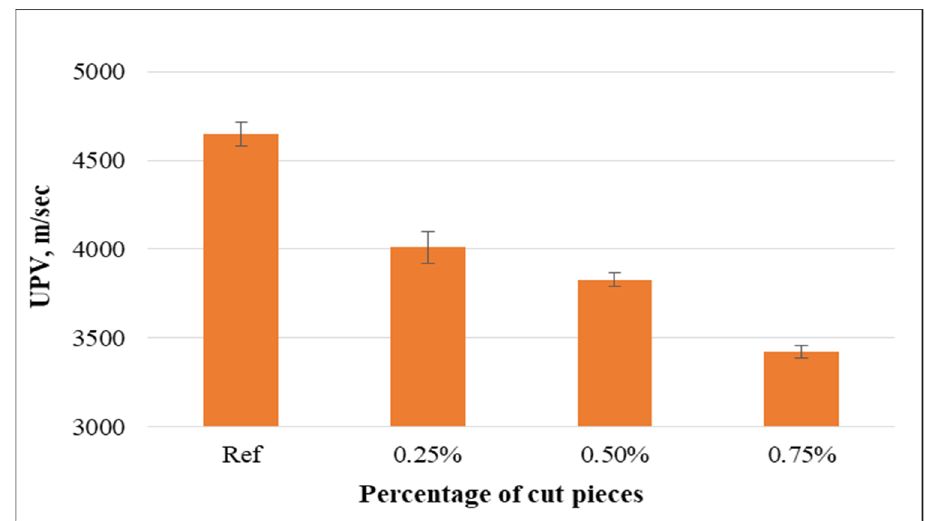
Figure 23. Relationship between UPV and volume fraction of non-woven cut pieces.